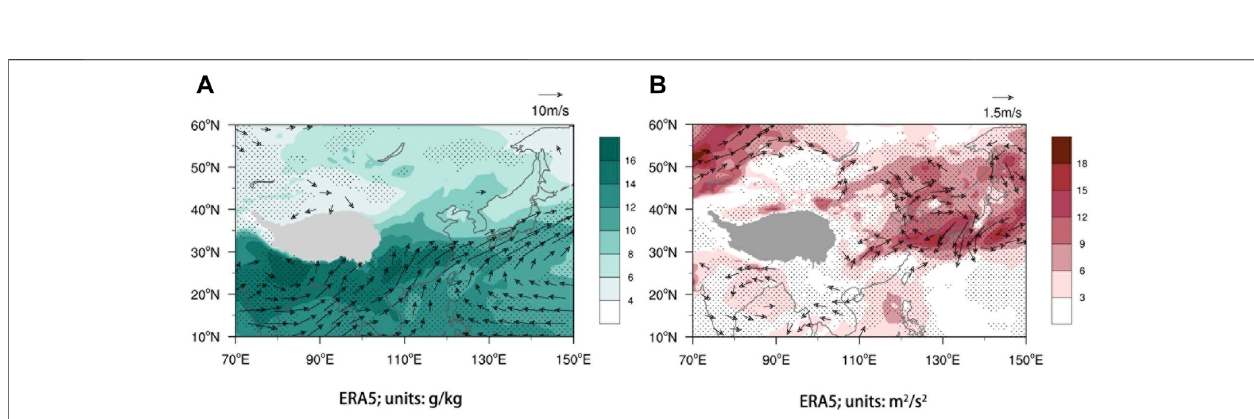
FIGURE 11 | (A) Same as Figure 2A but for the power spectrum analysis of precipitation from May to August of 2020 (B) Same as Figure 4B but for the 2020 PHREs.